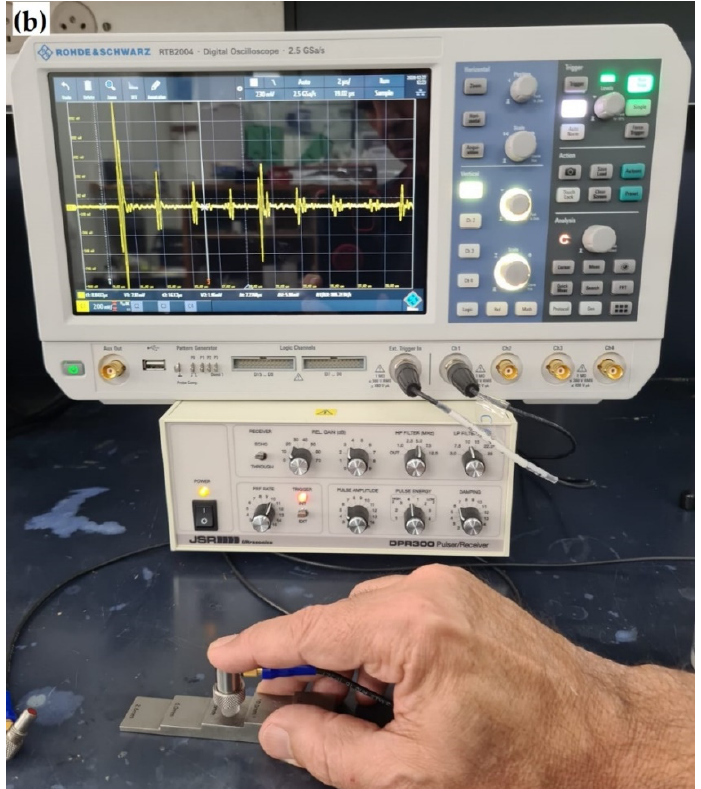
Figure 4. ( a ) Schematic illustration of the pulse-echo ultrasonic setup used for measuring the TOF in Ti6Al4V polygon samples. ( b ) Testing of a standard calibration specimen made of 304 stainless steel.